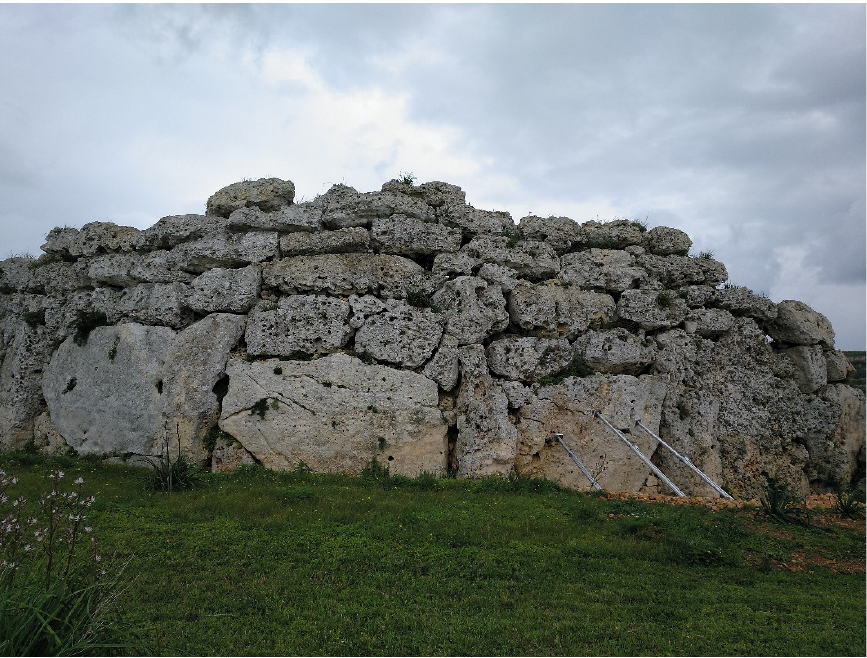
Figure 7. Ġ gantija, the Megalithic Temples of Malta.